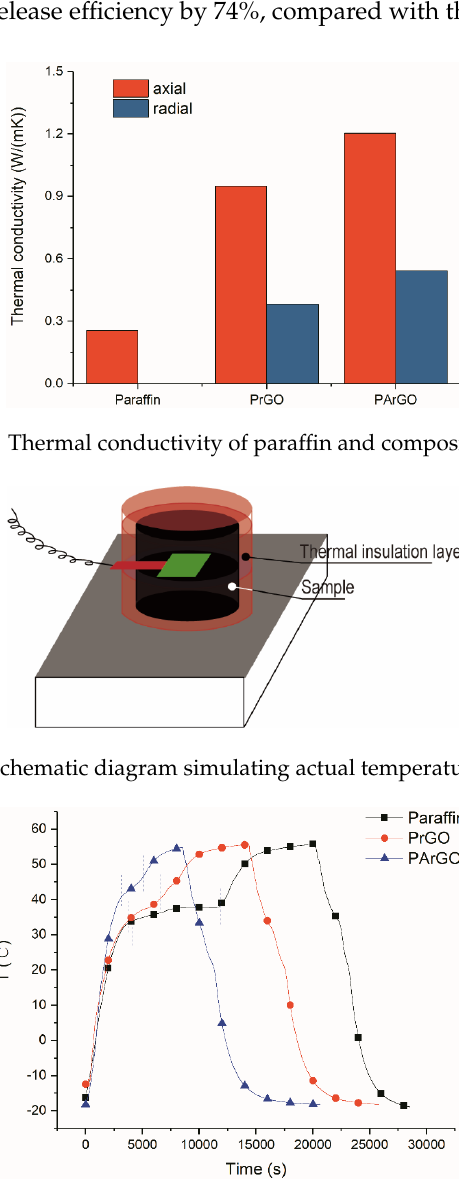
Figure 6. Thermal conductivity of paraffin and composite PCMs.